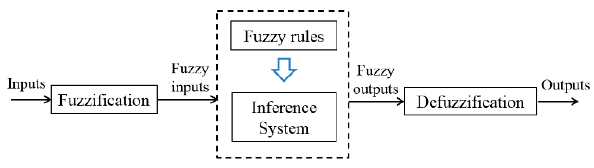
Figure 12. Scheme of a fuzzy system.